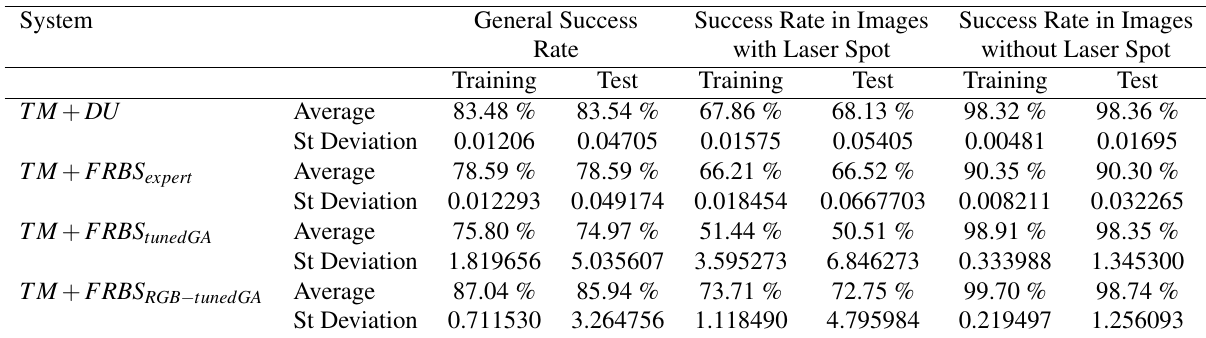
Table 5. Results of the proposed approach and comparison with the previous